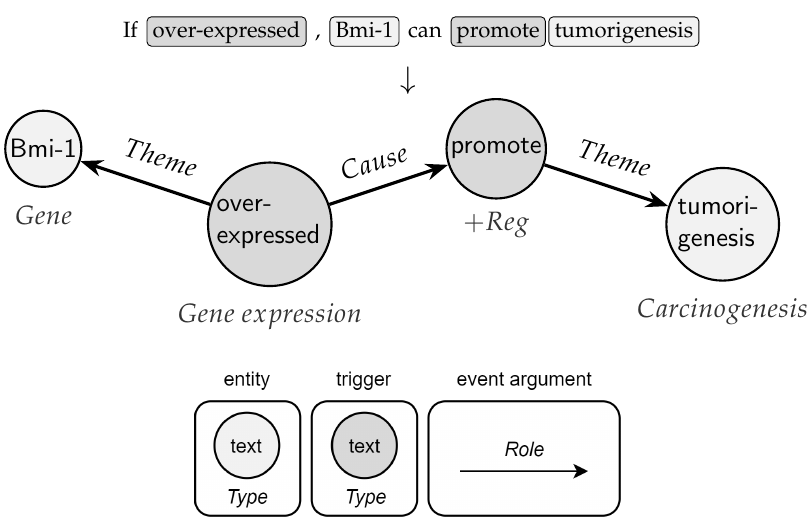
Figure 1. A biomedical event graph extracted from a sentence. The example exhibits two nested events: (i) a Positive regulation event (+Reg), anchored by a trigger “promote”, affecting “tumorigenesis” as Theme argument; (ii) a Gene expression of “Bmi-1” with (i) as Cause argument.